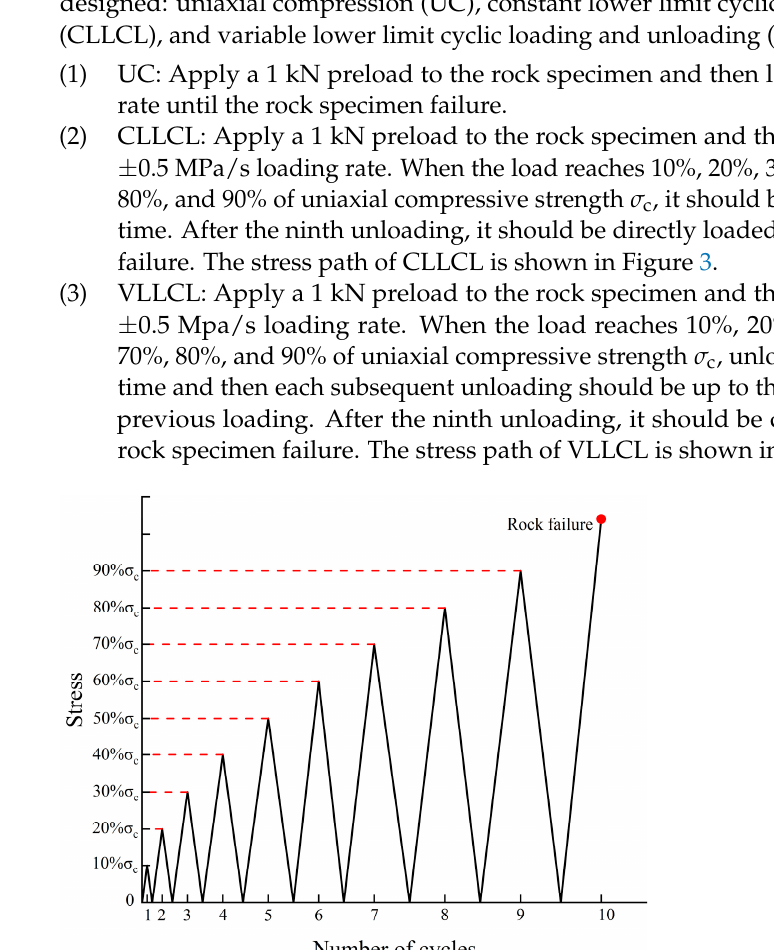
Figure 2. Schematic diagram of testing.